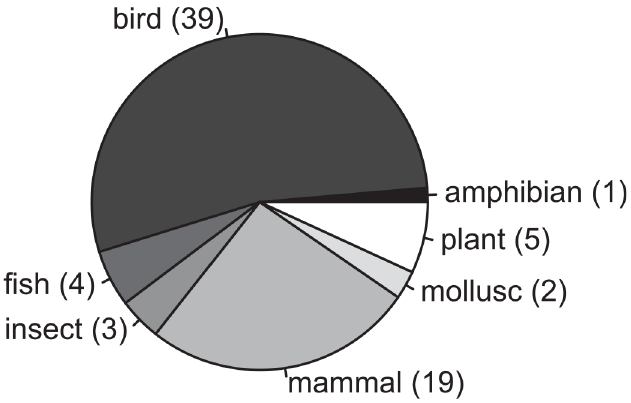
Fig 1. Taxonomic representation of the 72 data packages included in the survey. The number of packages for each taxon is given in parentheses (note: one data package included data describing both insects and plants [9], while other data packages represented multiple species within a single taxonomic category).